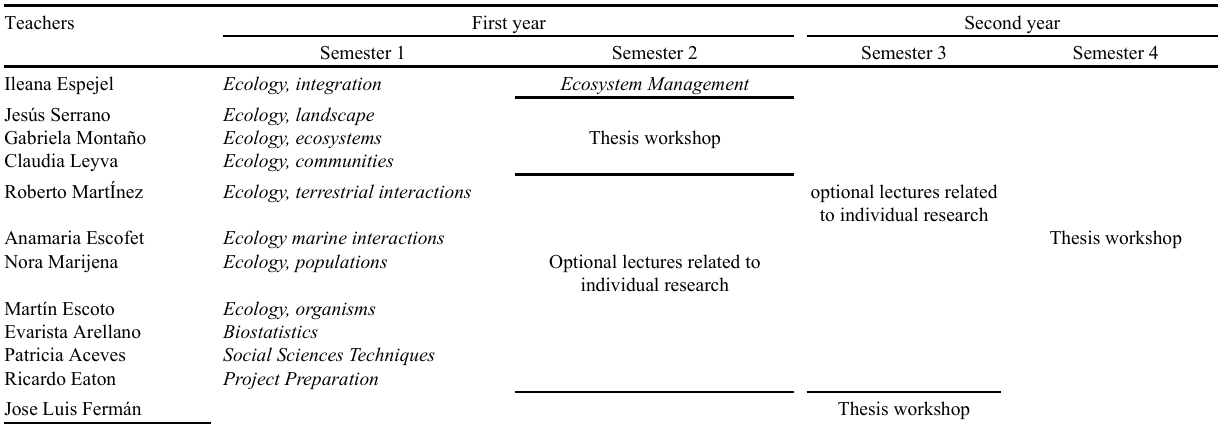
Table 2. Study plan of MEZA